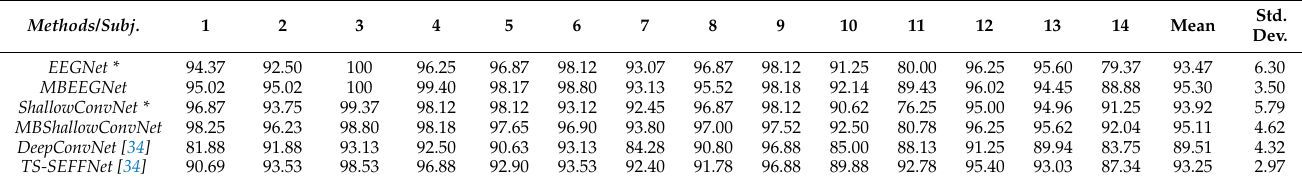
Table 8. Classification accuracy (%) on the HGD.